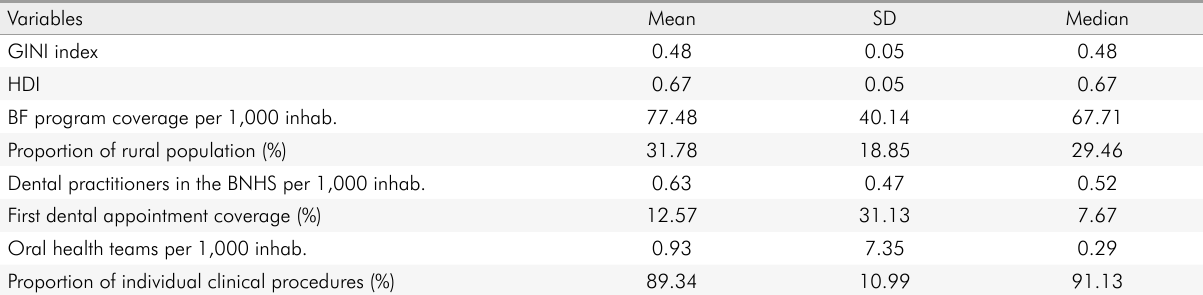
Table 3. Socioeconomic and oral health services’ characteristics from the 375 municipalities in the state of Minas Gerais, 2017.